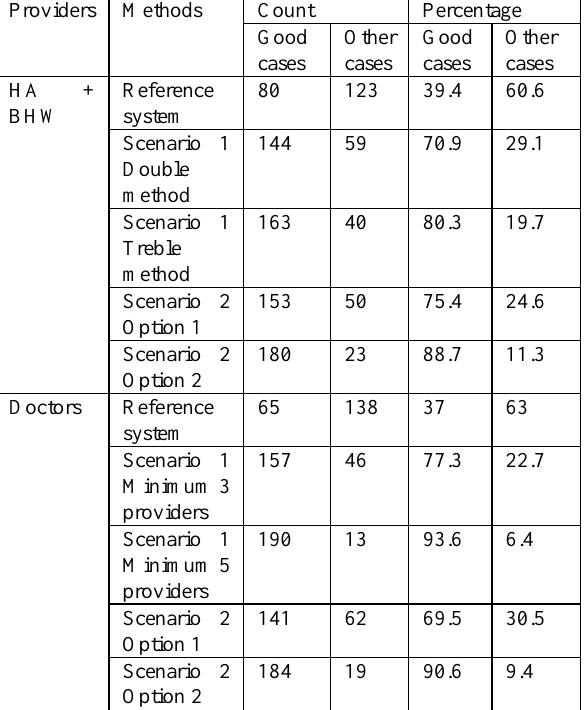
Table 1: Accessibility results of different policy scenarios Figure 12: Classification of sub-districts - Scenario 1 Minimum